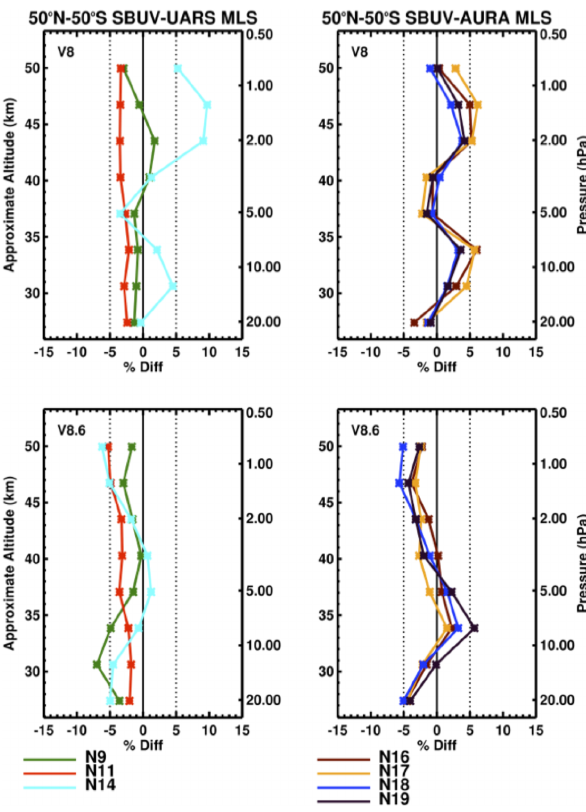
Fig. 4. SBUV minus MLS difference profiles averaged from 50 ◦ N to 50 ◦ S. Top panel shows differences using Version 8 SBUV, and bottom panel shows differences using Version 8.6 SBUV. NOAAs 9/11/14 are compared to UARS MLS, and NOAAs 16/17/18/19 are compared to AURA MLS. N17 difference profiles, shown in or- ange in the right-side panels, can be compared with results shown in Figs. S3 and